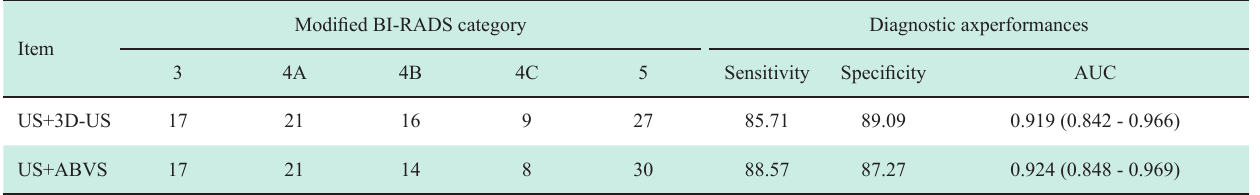
US, ultrasound; 3D-US, three-dimensional US; ABVS, automated breast volume scanner; BI-RADS, breast imaging reporting and data system; AUC, area under the